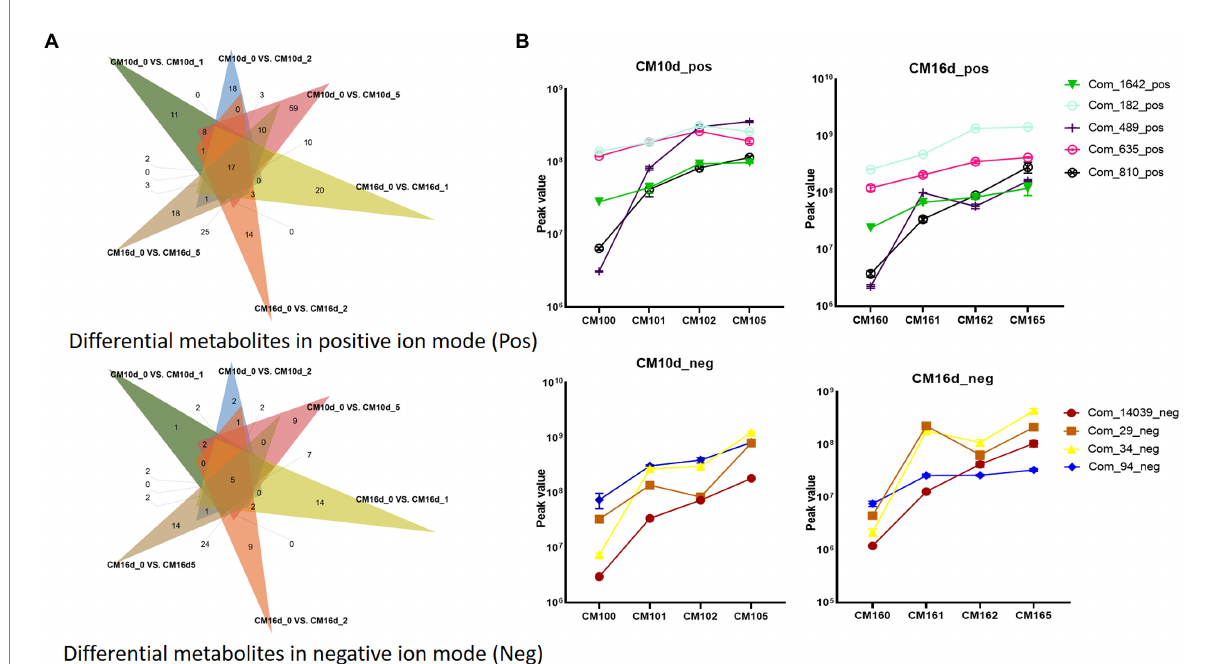
FIGURE 2 Metabolomic analysis of culture medium of S. vaninii mycelium. (A) Venn diagram of differential metabolites screening. (B) Peak value trend of screened metabolites.